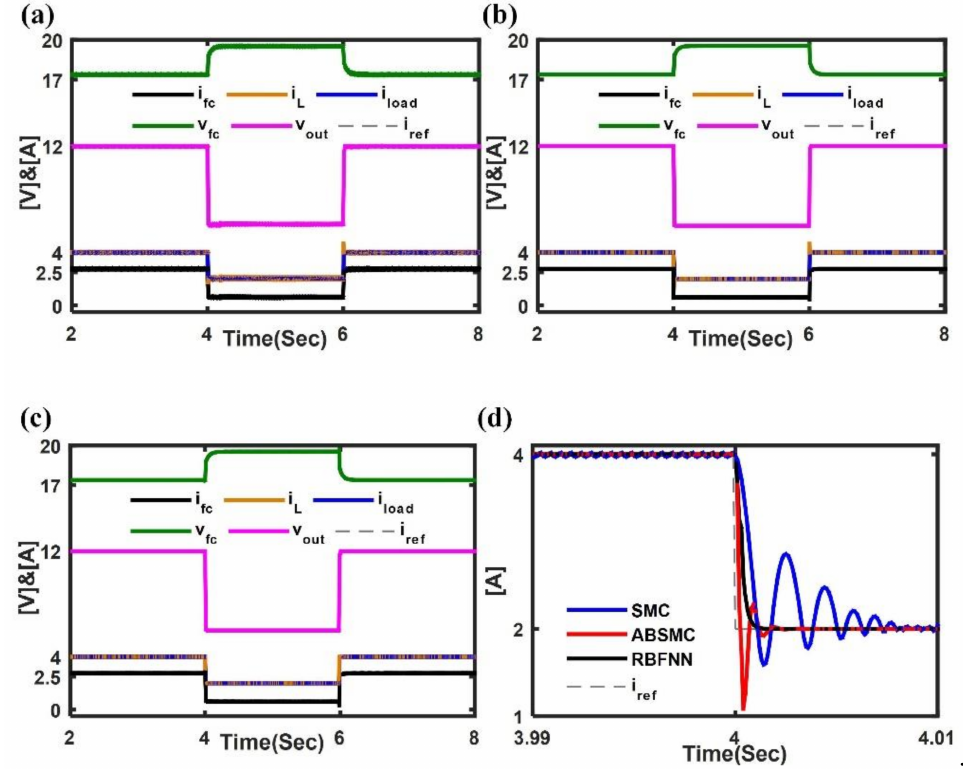
Figure 5. Simulation results in Condition 2: ( a ) by SMC; ( b ) by adaptive backstepping SMC; ( c ) by RBFNN; ( d ) inductor current controlled by different control methods, enlarged view at 4